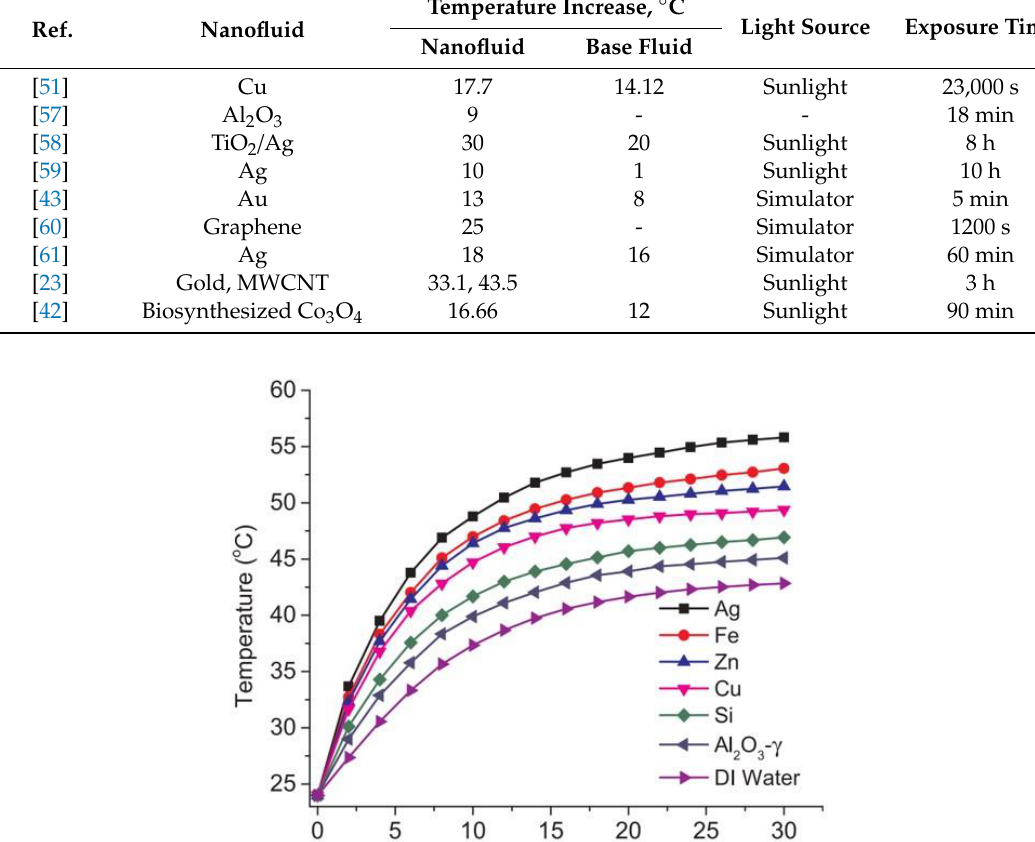
Table 2. Temperature rise achieved for various nanofluids [36]; 2019, Elsevier. Ref.